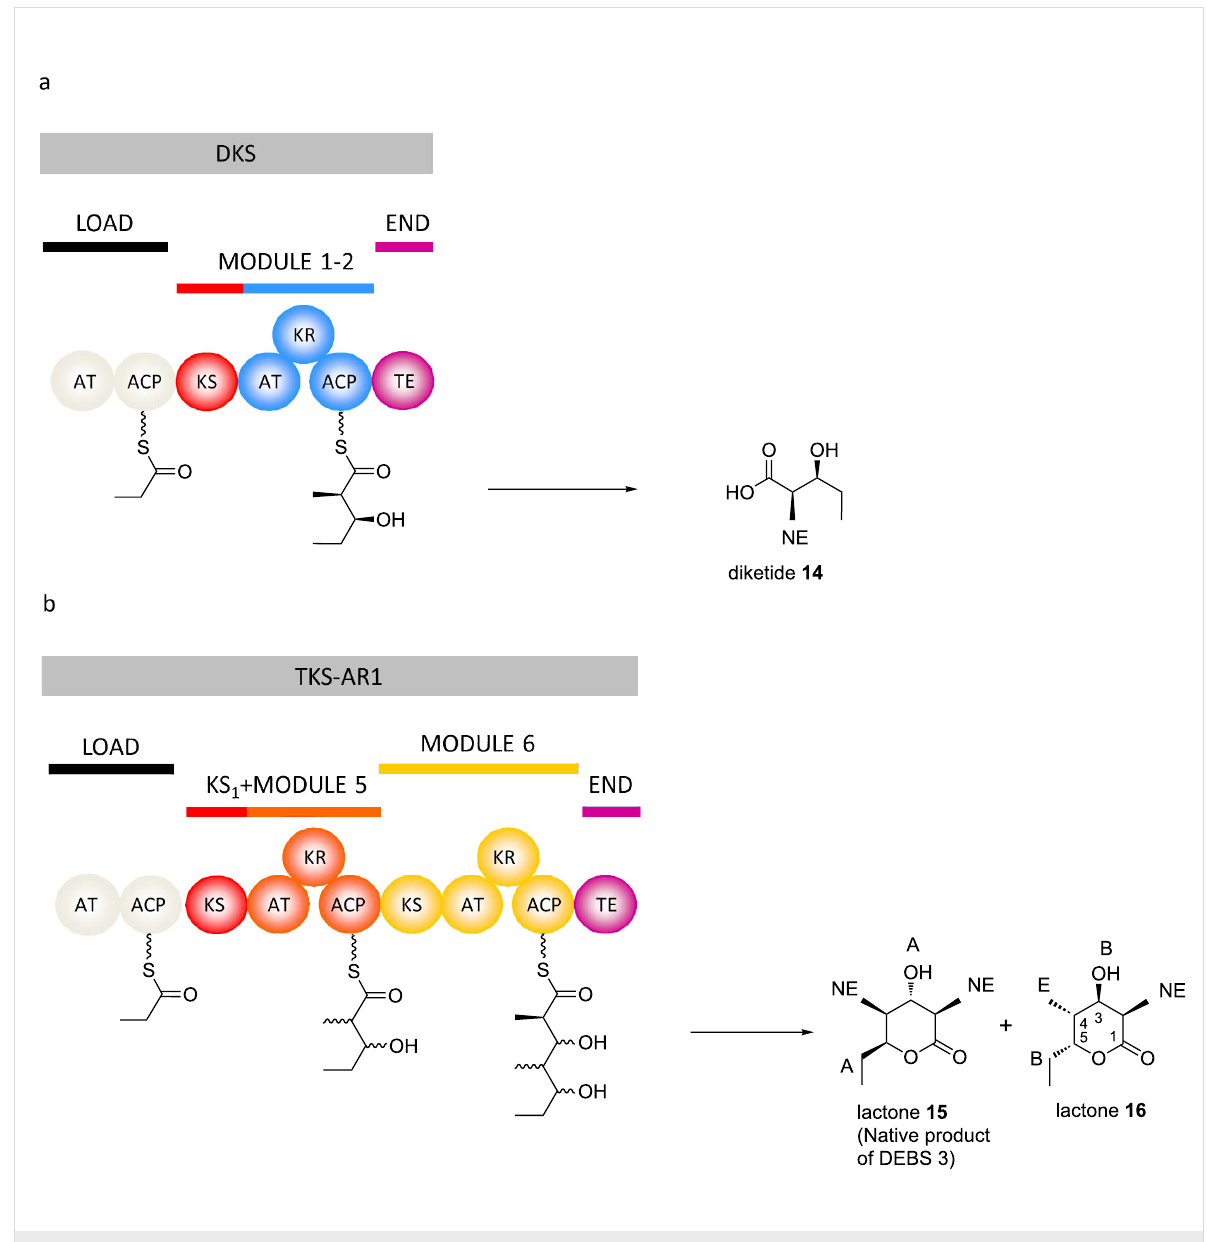
Figure 10: Genetic engineering experiments which suggested a role for the KS domain in epimerization. a) A diketide synthase (DKS) was created by attaching the loading module and KS 1 of DEBS to the remainder of DEBS module 2, which was itself fused to the thioesterase (TE) domain [47]. The resulting construct yielded diketide 14 in which the methyl group at C-2 was not epimerized (NE). As the diketide generated by module 1 normally in- corporates an epimerized methyl, this result was taken as evidence that KS 1 can produce both epimerized and unepimerized methyl groups, and